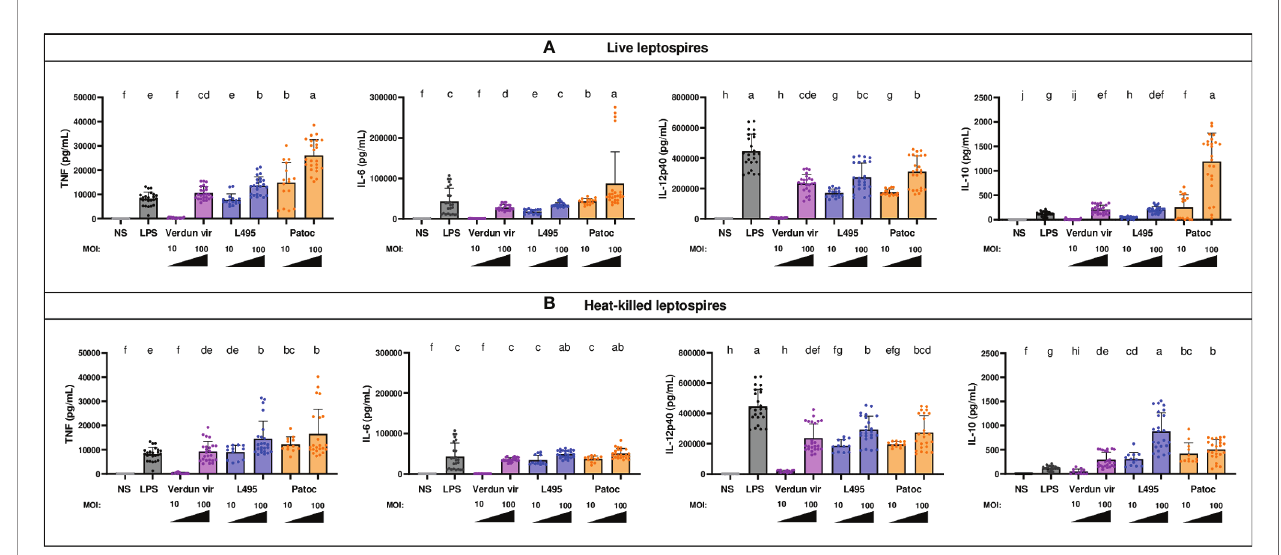
FIGURE 2 | BM-DCs from C57BL/6 mice exposed to live and heat-killed leptospires produce more pro- and anti-in fl ammatory cytokines. Day 8 BM-DCs from C57BL/6 mice were exposed to either live (A) or heat-killed (B) Icterohaemorrhagiae Verdun vir, Manilae L495 and Patoc leptospires at a Multiplicity of Infection (MOI) of 10 or 100 bacteria per cell for 24h. E . coli LPS (1 µg/mL) was used as a positive control for DCs stimulation. After 24h, cytokine concentrations were quanti fi ed in cell supernatants by ELISA assays and data were compared to results with non-stimulated cells (NS). Data are represented in histograms with dot plot showing the concentration of pro-in fl ammatory TNF, IL-6 and IL-12p40 and anti-in fl ammatory IL-10 in cell supernatants. Each dot represents one out of four replicates of stimulation from fi ve independent experiments with n=6 mice. Mean ± SD is also represented. Statistics indicated with lower-case letters allow for comparing, for each cytokine all conditions within live (upper panel) and heat-killed (lower panel). Conditions that share the same lower-case letters are not signi fi cantly different (p > 0.05). In contrast, conditions that do not share same letter(s) are signi fi cantly